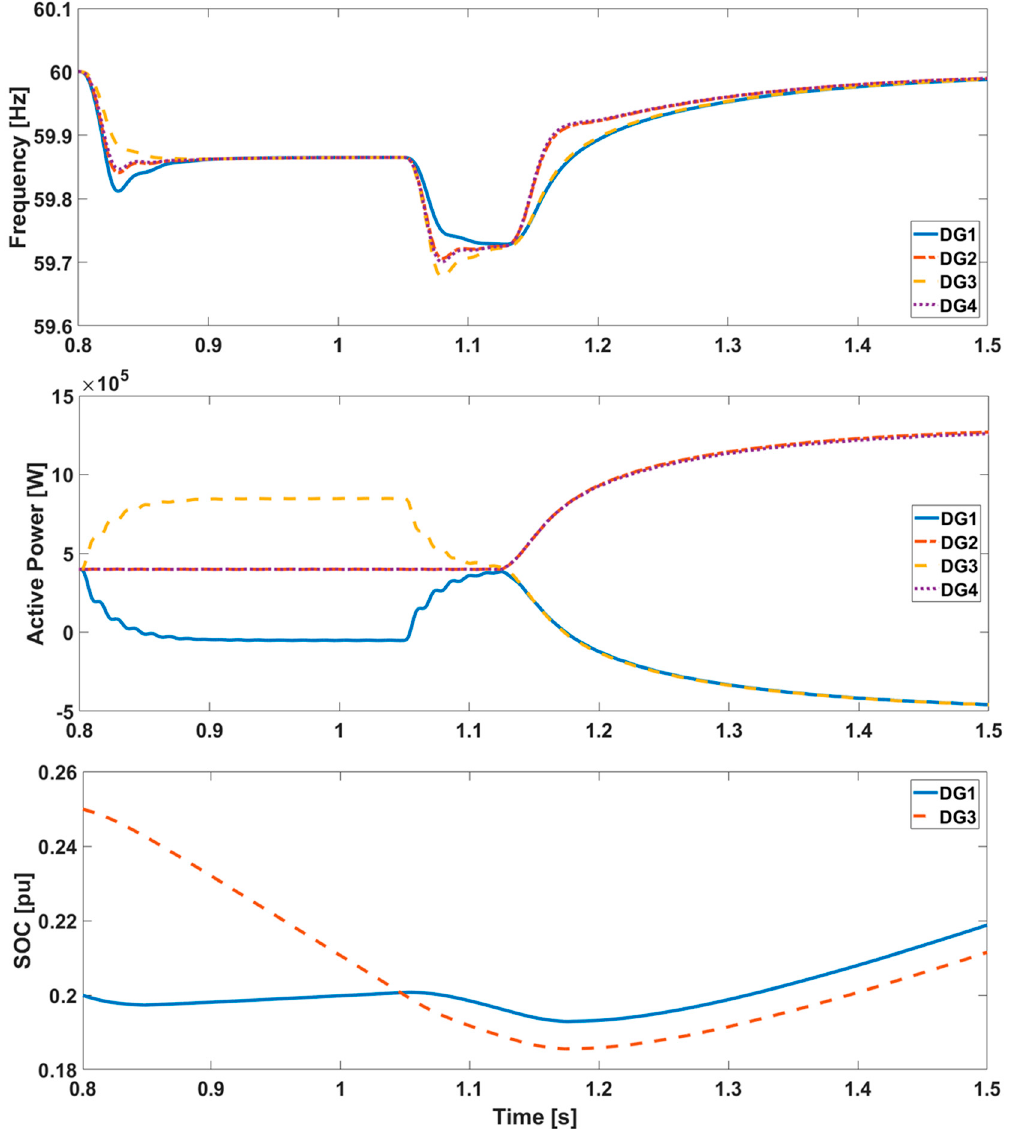
Figure 9. SOC restoration results for SOC difference of 5% between DG1 and DG3.